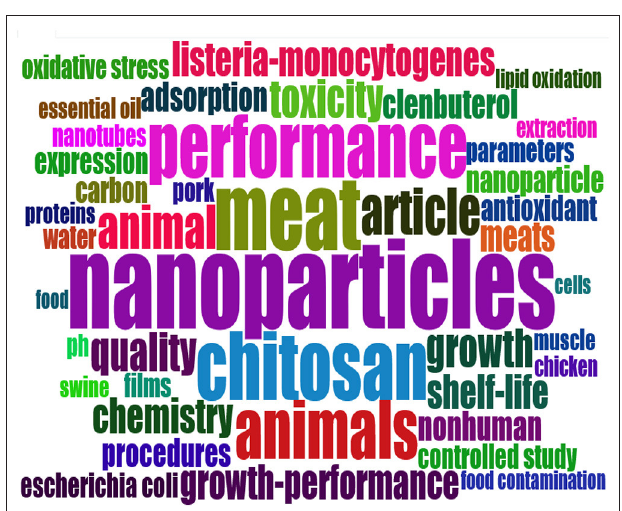
FIGURE 7 | Word cloud on nanotechnology and meat production